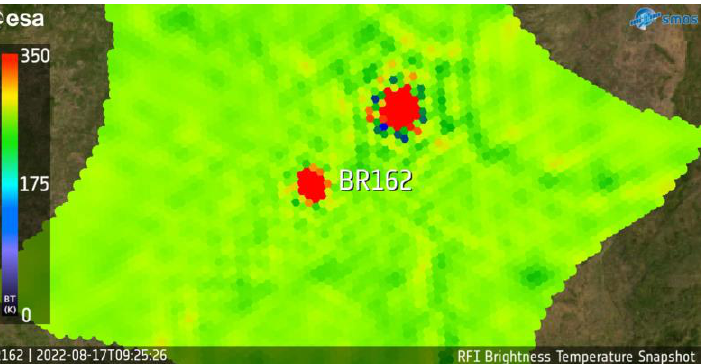
Figure 4. SMOS RFI Brightness Temperature map for a specific RFI source generated automatically by dedicated scripts at ESAC.